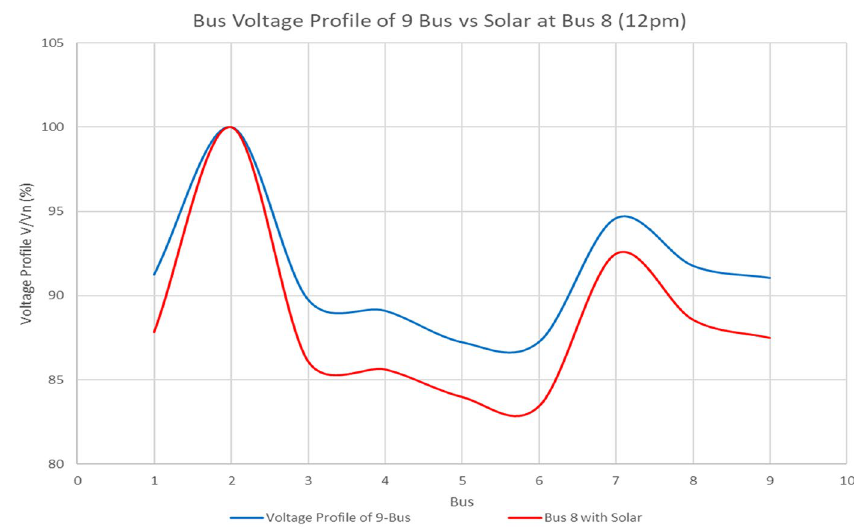
Fig. 8 Bus voltage profile of IEEE-9 Bus versus IEEE-9 bus with solar at 12 pm